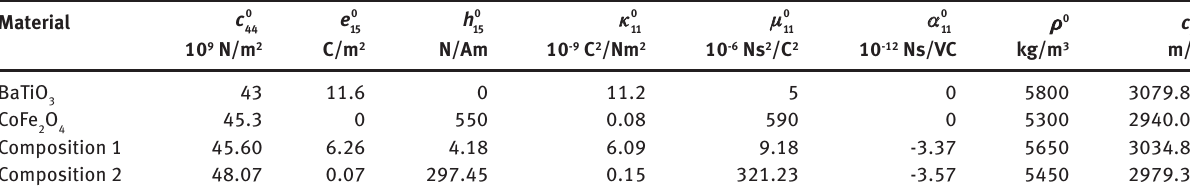
Table 1: Material